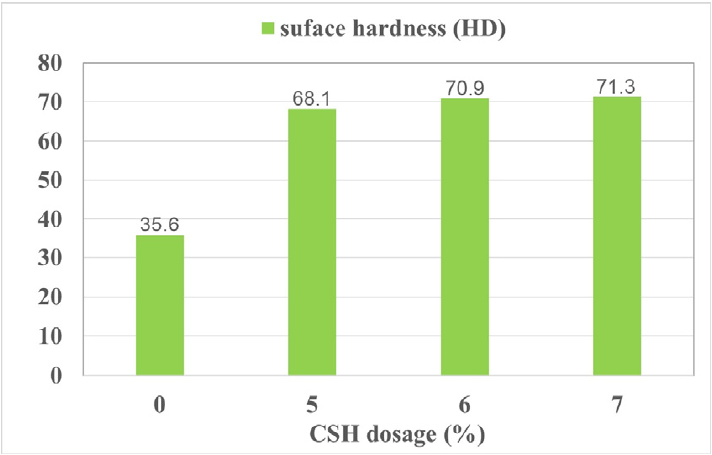
Figure 11. The surface hardness change in the bone samples after consolidation by CSH.